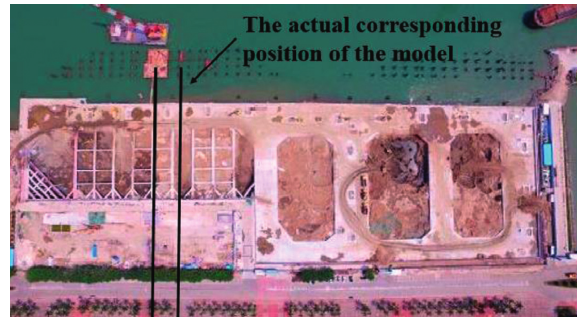
Figure 12: Plane diagram of model for impact analysis of wave load on the foundation pit.